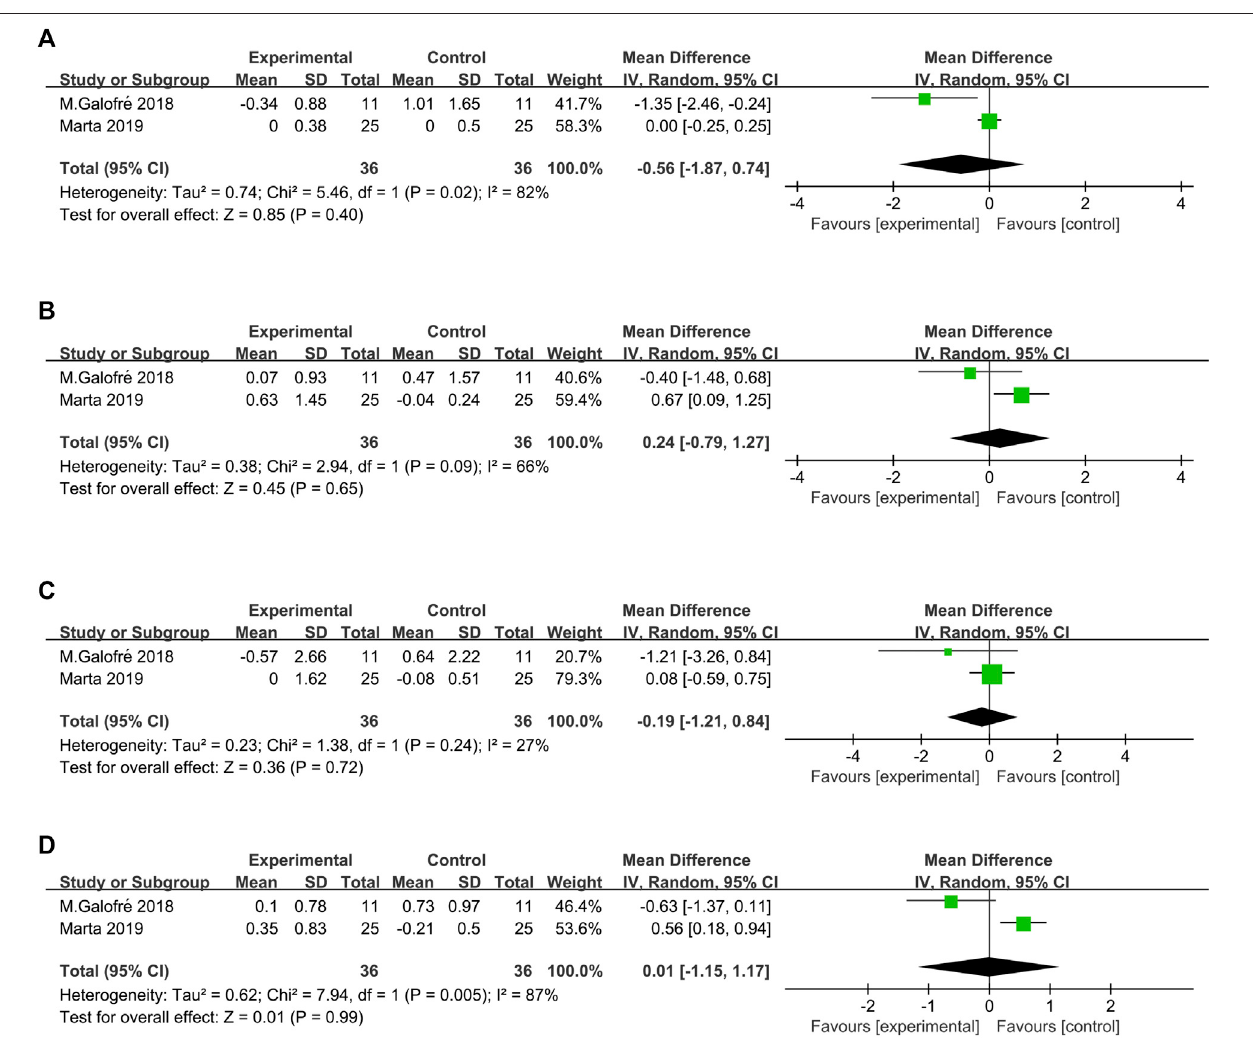
FIGURE 5 | Forest plot of the microorganism load regarding the established subgroups: (A) P. gingivalis ; (B) P. intermedia ; (C) T. forsythia ; (D) F. nucleatum .